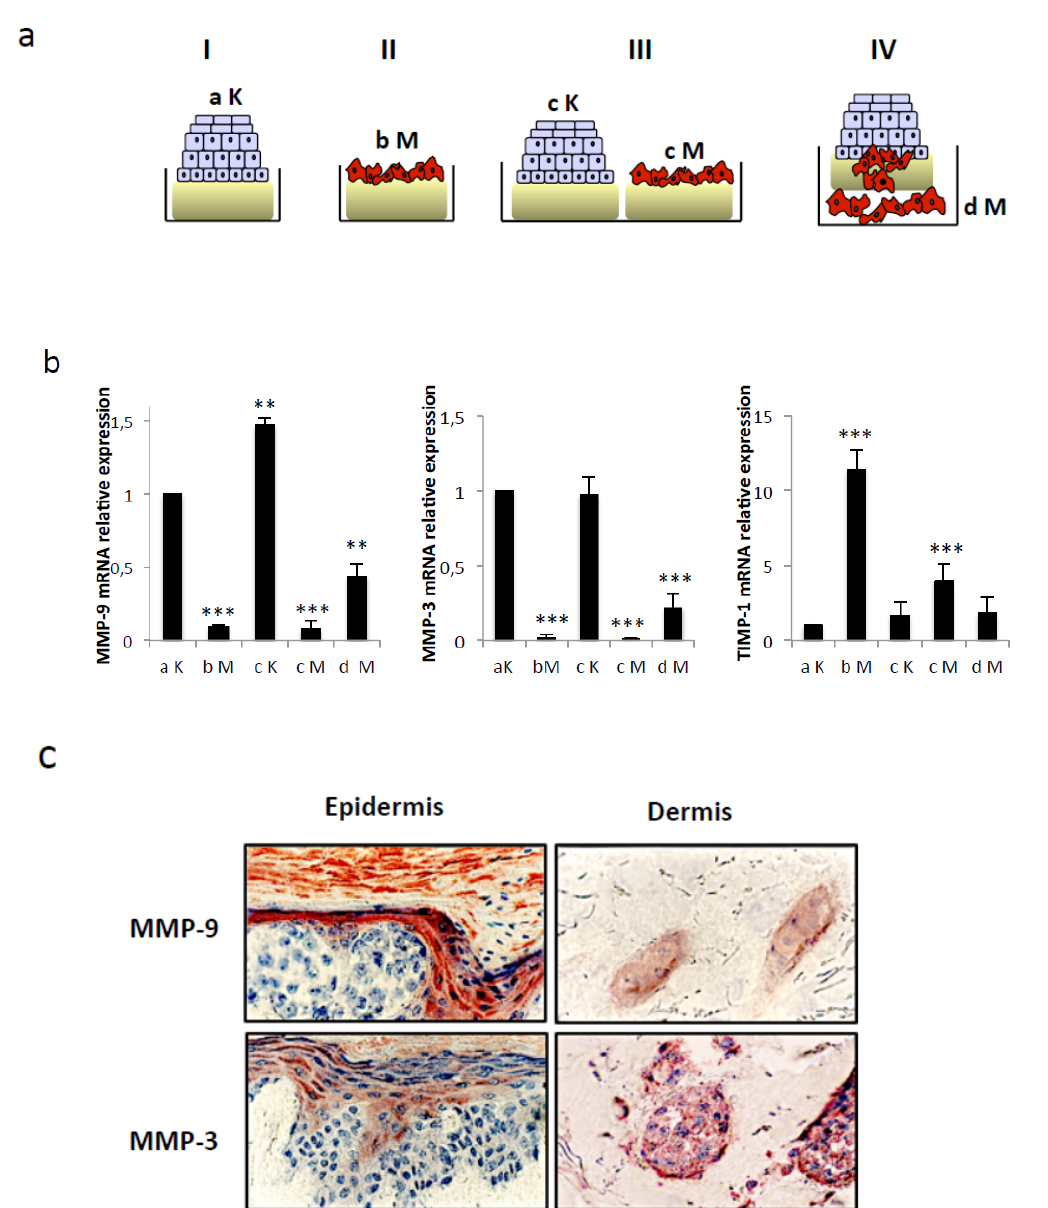
Figure 6. Keratinocytes are the main source of MMP-3 and MMP-9 in the epidermis but melanoma cells gain the ability to express both proteins after DEJ crossing. ( a ) Total RNA has been isolated from keratinocytes and Tspan8+ melanoma cells at day 20 from the four different schematized culture conditions. aK: keratinocytes from culture I; bM: Tspan8 + melanoma cells from culture II; cK and cM: keratinocytes and Tspan8 + melanoma cells from culture III respectively; dM: invading melanoma cells from culture IV. ( b ) QPCR analysis of MMP-9 , MMP-3 , and TIMP-1 transcript expression levels of aK, bM, cK, cM and dM ( n = 3; ± SD). ( c ) Representative pictures of immunohistochemical staining of MMP-9 and MMP-3 in the epidermis and dermis of SR integrating Tspan8 + melanoma cells (condition IV) at day 20. ** p < 0.01, *** p < 0.001.